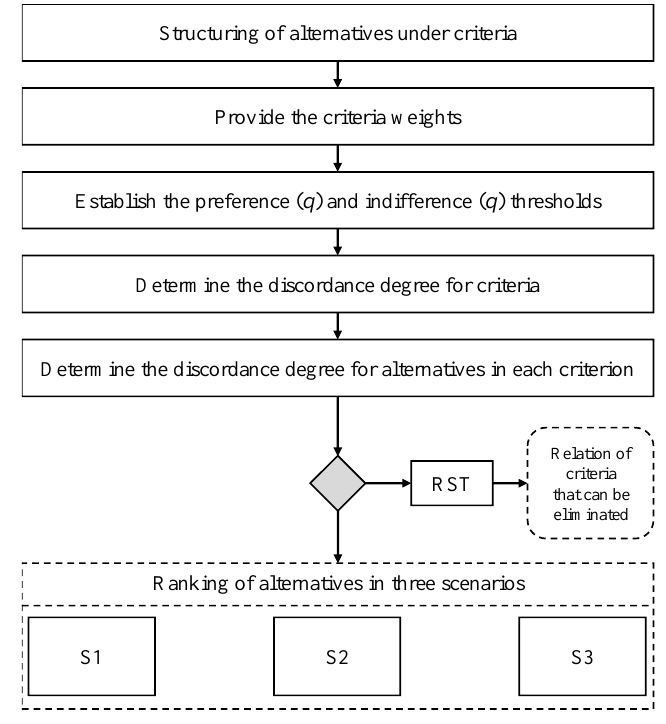
Figure 4. Axiomatic structure of the THOR method.